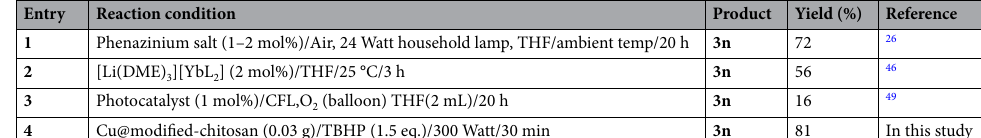
Entry Reaction condition Product Yield (%) Reference